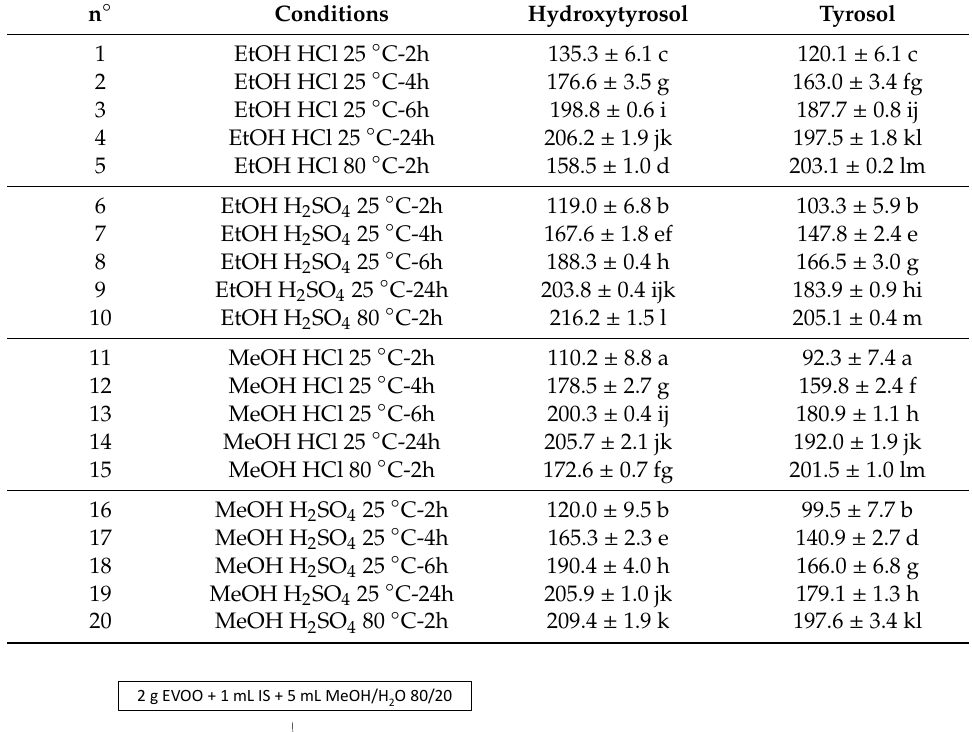
Table 1. Evaluation of the maximum recovery in terms of OH-Tyr and Tyr after di ff erent hydrolysis methods in acidic media; the analyses were applied to the MIX-17 sample; the data are a mean of triplicates expressed as mg / kg. Under the column, condition, the authors specified (i) the extraction solvent (EtOH = EtOH:H 2 O 80:20; MeOH = MeOH:H 2 O 80:20), (ii) the acid used for hydrolysis (HCl = HCl 2 M; H 2 SO 4 = H 2 SO 4 1M), (iii) the hydrolysis temperature and iv) the hydrolysis time. In each column, di ff erent letters indicate statistical di ff erences at p 0.05.